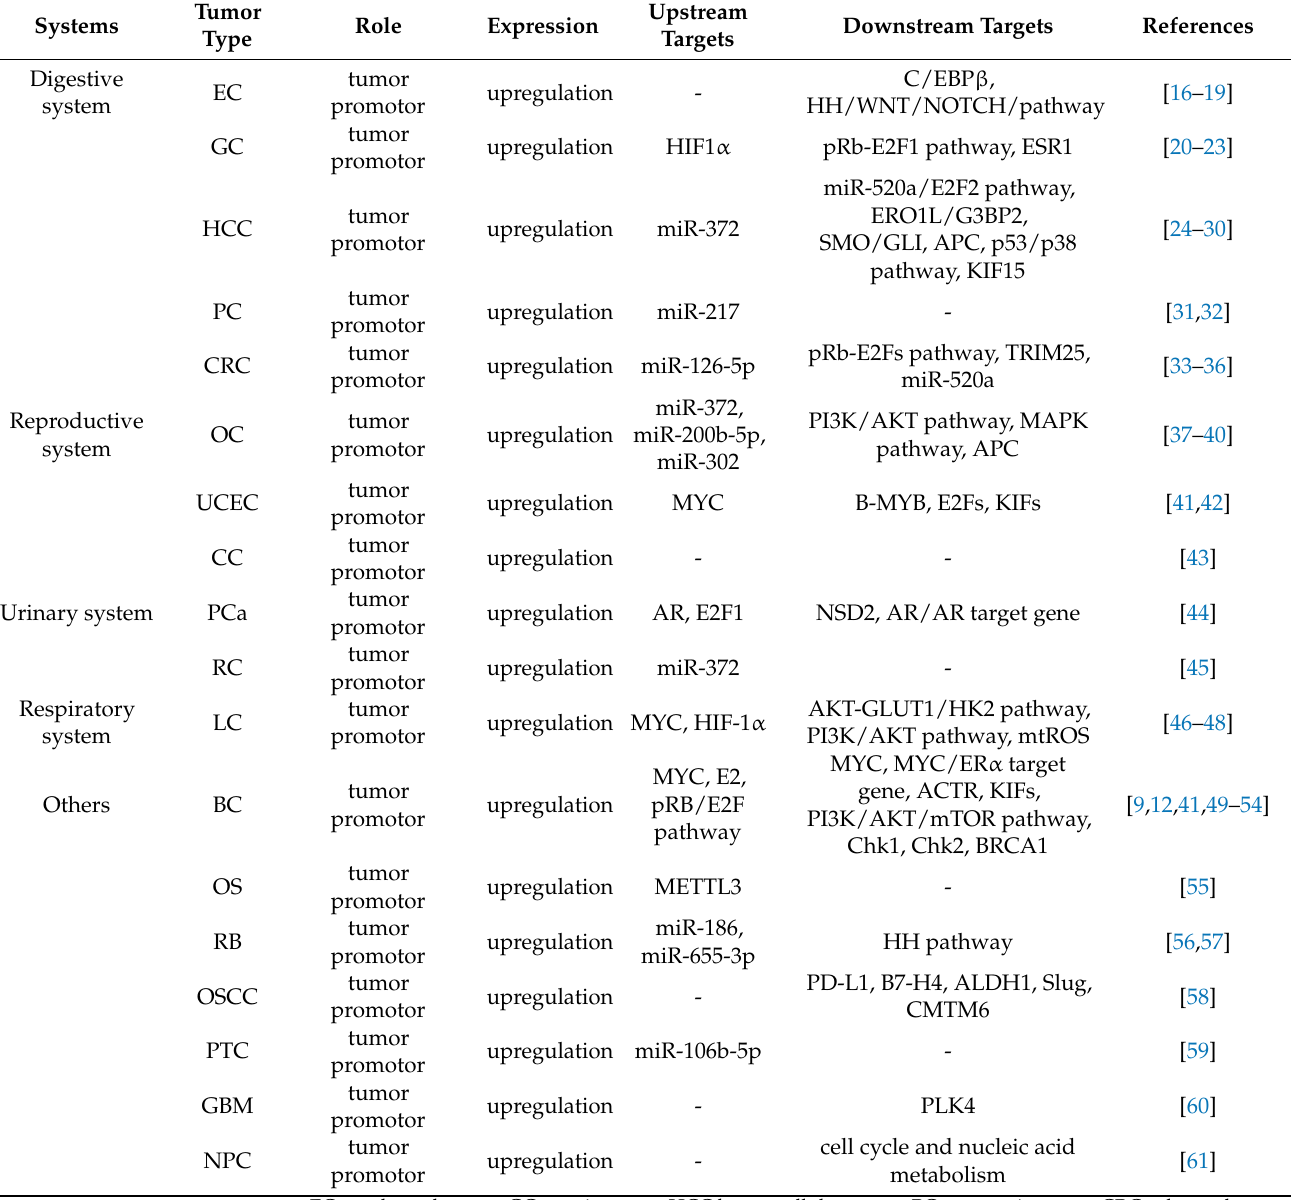
Table 1. Expression profiles and upstream and downstream targets of ATAD2 in human